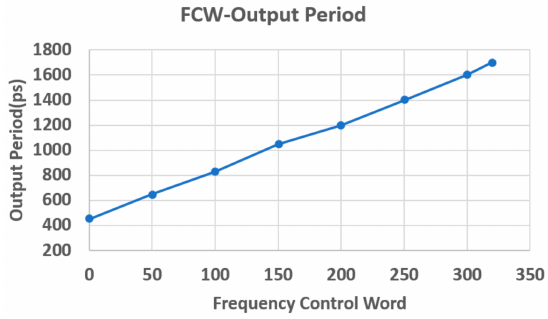
Figure 9. Frequency vs. Control word of the